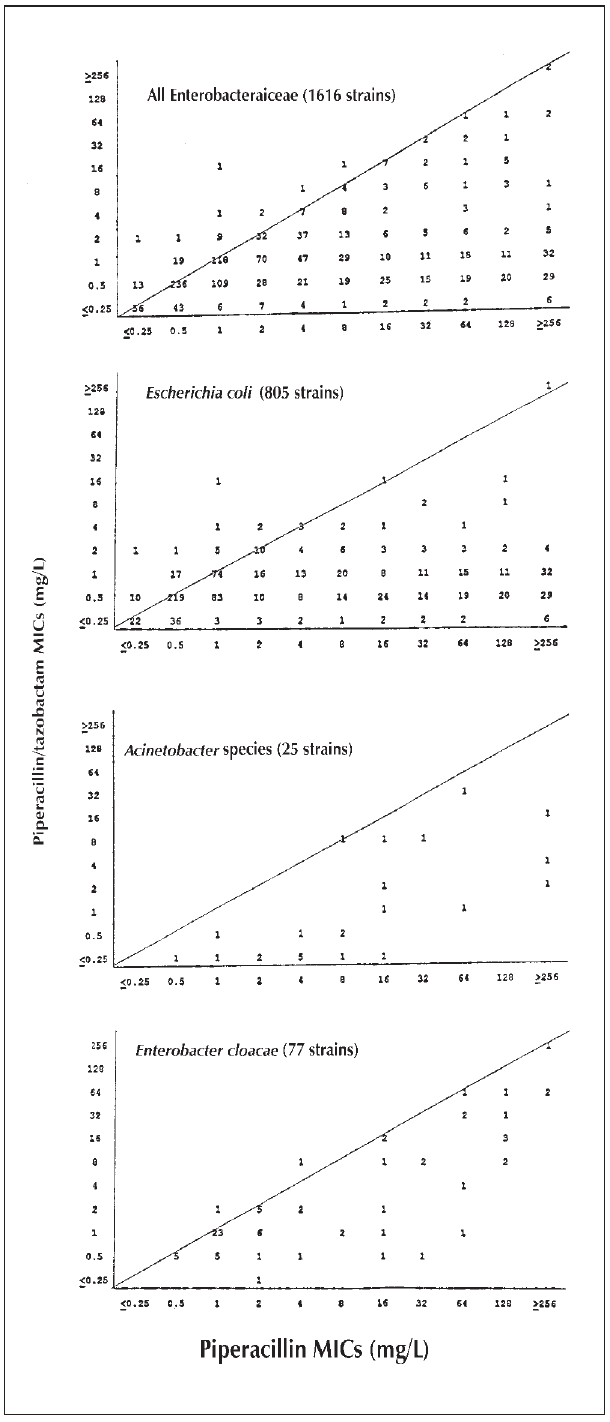
Figure 1) Comparison of the minimal inhibitory concentration (MIC) of piperacillin alone with that of piperacillin/tazobactam (8:1